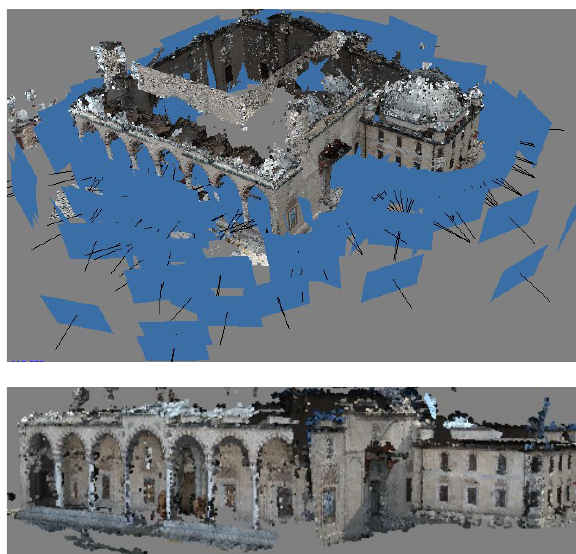
Figure 7. Dense point cloud model